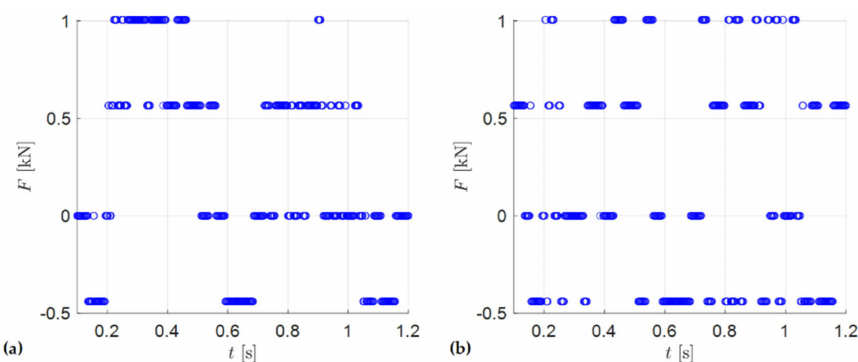
Figure 8. Force delivered by the hydraulic cylinders to support the required knee torque at different knee angles: ( a ) cylinder for mechanism 1; ( b ) cylinder for mechanism